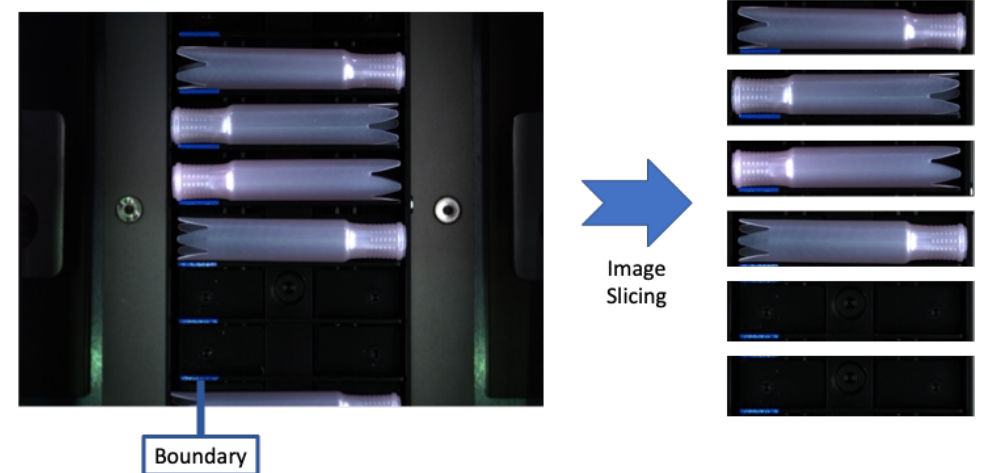
Figure 14. Image slicing by crop logic.